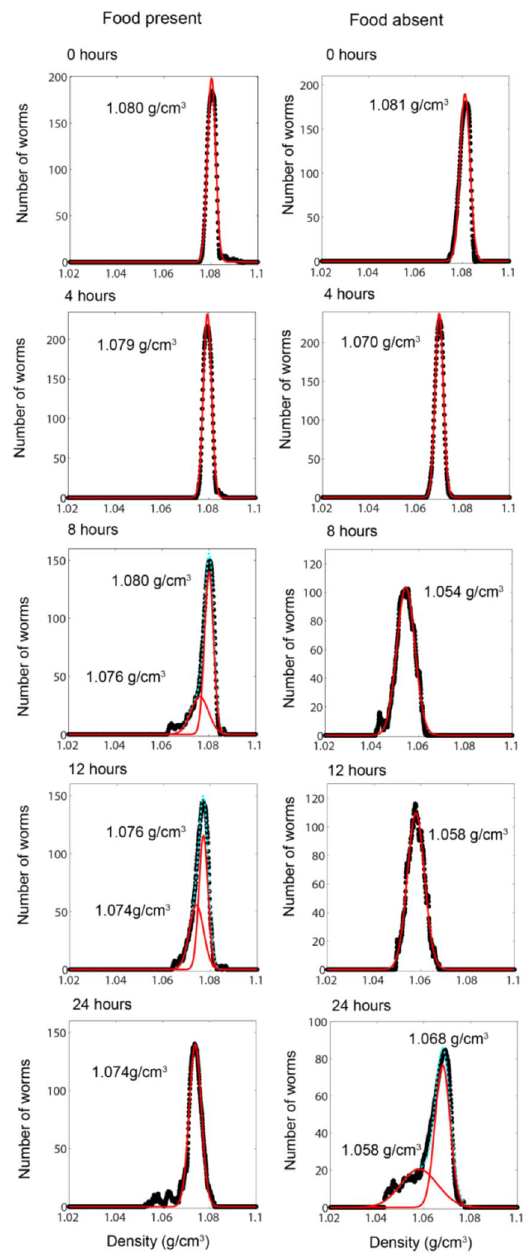
Figure 3. Changes in the distribution of mass densities of adult C.elegans subjected to caloric restriction. Each panel shows the distribution of densities of well-fed and starved worms at the indicated times. 0 hour corresponds to the time point immediately after the L4/ adult molt. The red lines are Gaussian fits to the data and the numbers indicate the location of the peak(s) in the distributions.